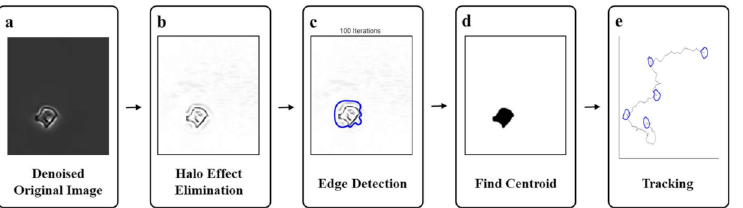
Figure 1. Entire pipeline of the cell segmentation and tracking algorithm. ( a ) is a denoised original image, which is obtained using the method described in the next section. ( b ) shows Halo effect elimination image. After denoising, the Halo effect remains, and Halo effect elimination is performed. ( c ) is the edge detection process. ( d ) shows the center point finding for cell tracking. ( e ) shows the cell tracking result using the proposed methods.